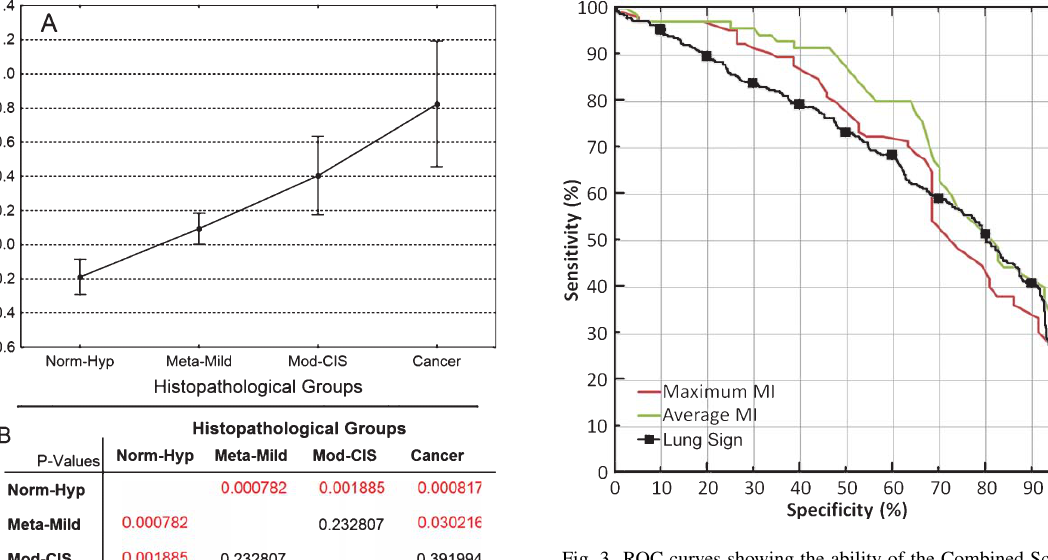
Fig. 3. ROC curves showing the ability of the Combined Score to distinguish between high- and low-m-risk patients. Patient m-risk groups were defined as described in the text. Patient m-risk can be defined using the maximum MI of the biopsies from the subject or the average MI from the biopsies taken from the subject, both cases for which are shown. For comparison, the ROC curve for LungSign is shown as well (adapted from Fig. 2 in [21]). Areas under the curve are 0.711, 0.766, and 0.692 for maximum MI, average MI, and LungSign,